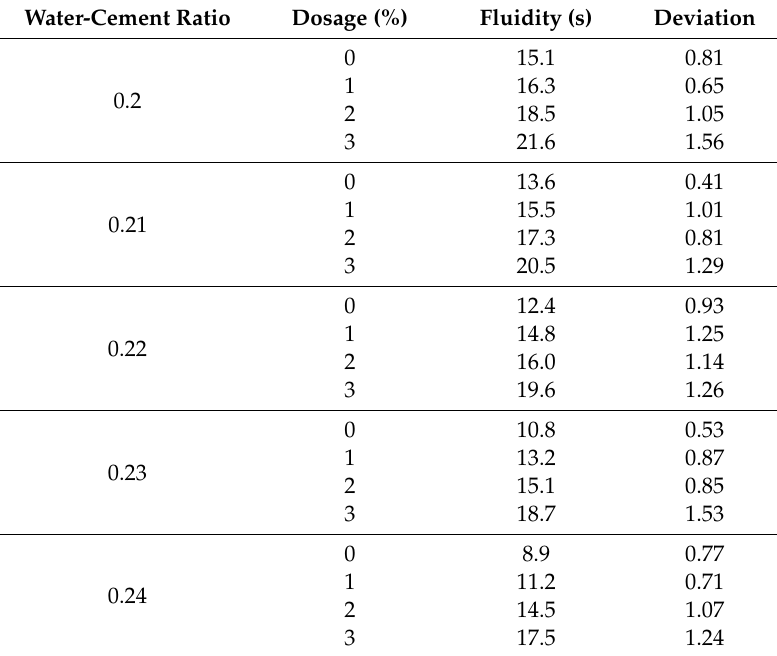
Table 6. Result of fluidity test of